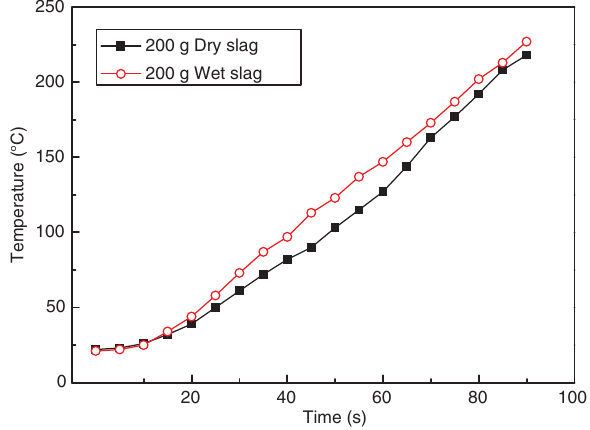
Figure 7: Variation of penetration depth of high titanium slag with moisture content.